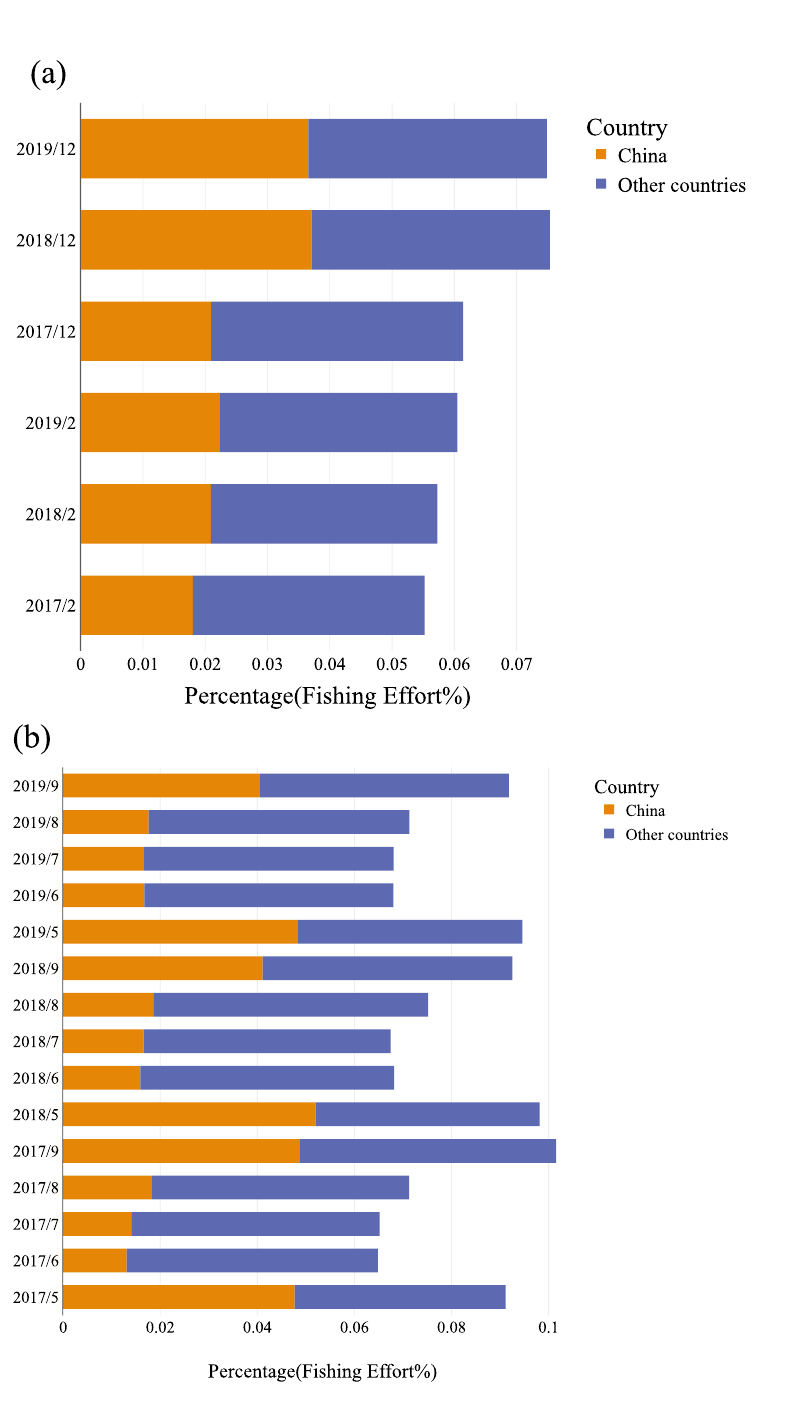
Figure 9. The impact of culture and policy on the percentage of fishing effort of China and other countries. ( a ) Impact of culture on fishing effort, ( b ) impact of policy on fishing effort. Further analyses were conducted by analyzing the impact of Chinese New Year on China’s fishing effort and Christmas’ impact on the fishing effort of all countries except China. The influence of culture and policy on this attribution of fishing effort by culture and policy was 5.76% and 12.83%, respectively. Hence, overall policies had a greater impact on monthly fishing effort. The average monthly proportion of fishing effort in the two months affected by culture and the five months affected by policy was similar at 2.88%, and 2.84%,